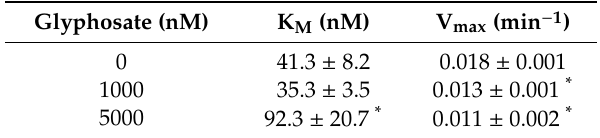
Table 2. Kinetic parameters obtained from the fitting of the data in Figure 2A to a Michaelis-Menten curve. The kinetic parameters are calculated for aromatase activity in the absence and presence of 1000 and 5000 nM of glyphosate.